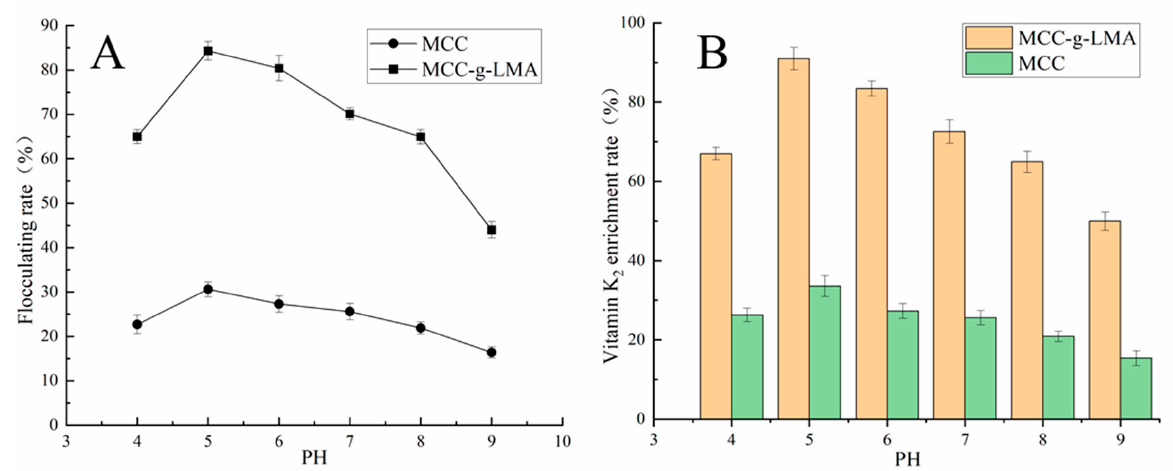
Figure 6. Effect of pH on ( A ) flocculation rate and ( B ) the enrichment rate of vitamin K 2.